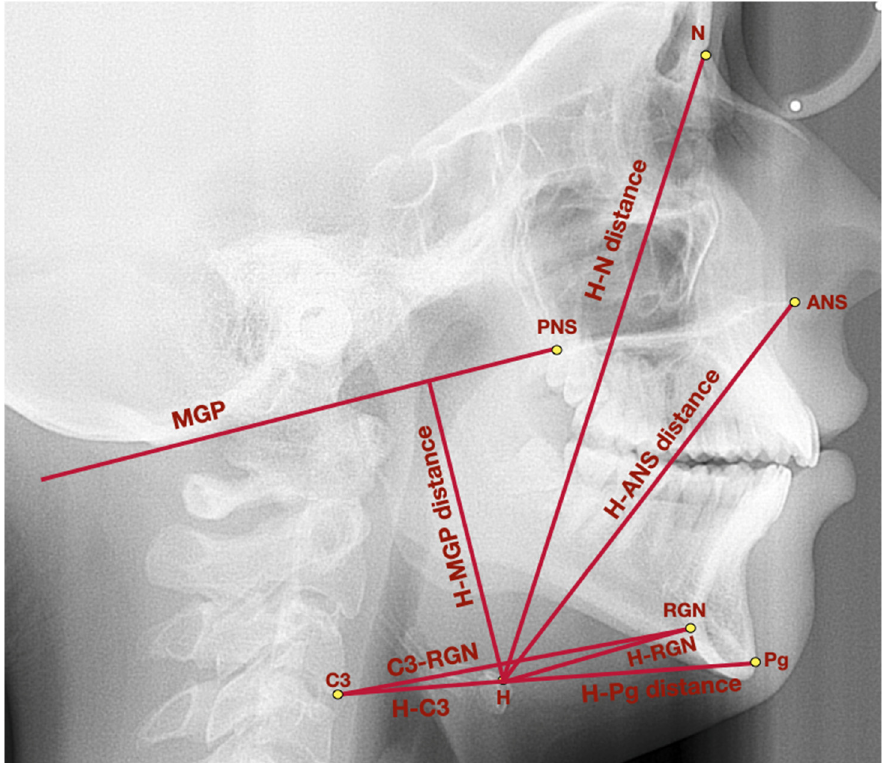
Figure 1. Lateral cephalogram with marked points, lines, and angles presented in Table 1 used to assess the hyoid triangle and the hyoid bone topography. ANS—anterior nasal spine, C3—third cervical vertebrae, H—hyoidale, MGP—McGregor’s Plane, N—nasion, Pg–pogonion, PNS—posterior nasal spine, RGN—retrognathion.